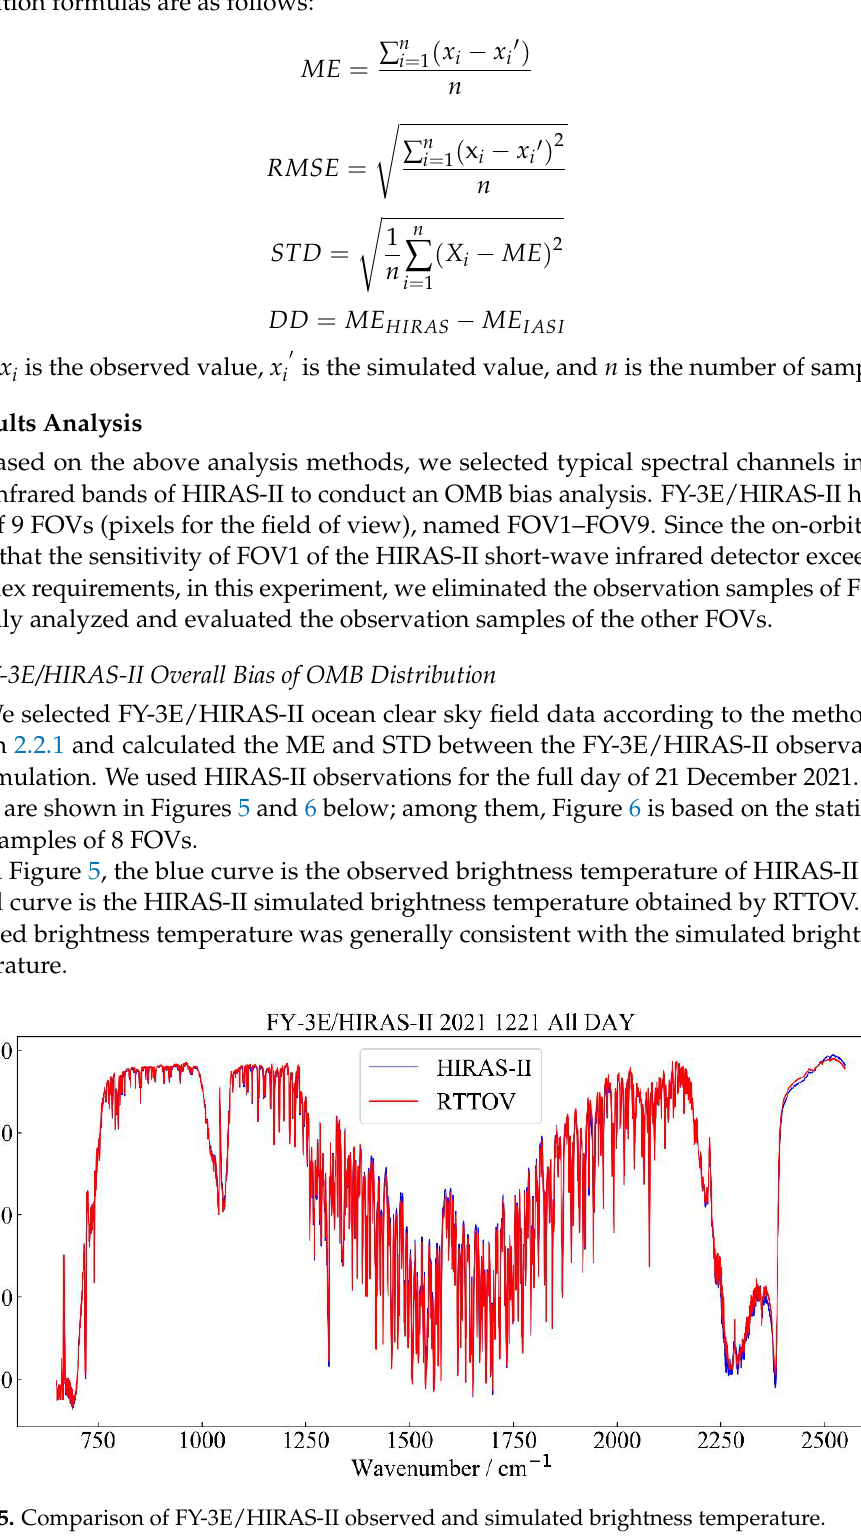
Figure 6. ME and STD of FY-3E/HIRAS-II observations and simulations. The red line in Figure 6 represents the mean bias of brightness temperature between the HIRAS-II observation and simulation, the pink shading represents the one-time STD fluctuation interval, and the black line is the OMB standard bias. Figure 6 shows that the ME of OMB in the long-wave and medium-wave infrared bands is ±1 K, except for the CO2 absorption band around 680 cm −1 and the ozone absorption band around 1000 cm −1 . In addition, the bias of the medium wave from 1600 to 1750 cm −1 fluctuates strongly, and we considered that the water vapor profile of ERA5 may be overestimated in the middle troposphere, which led to an error of about 2 K in the medium-wave water vapor absorp- tion [7]. From Figure 6, it can also be seen that the ME was in the range of ±2 K overall near the short wave and was greater than 5 K in some channels at 2250 – 2400 cm −1 . A sub- sequent detailed analysis of each FOV was carried out to check the deviation distribution of each FOV in the short wave. 3.2. The Bias of OMB Global Sample Distribution